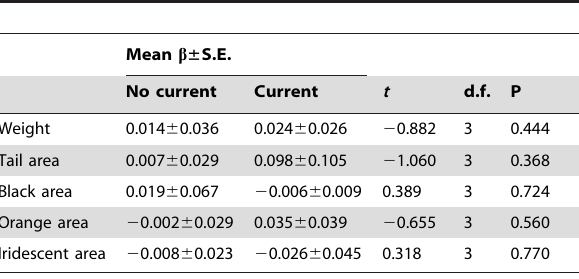
Table 2. Comparison of female preferences between the no current and current